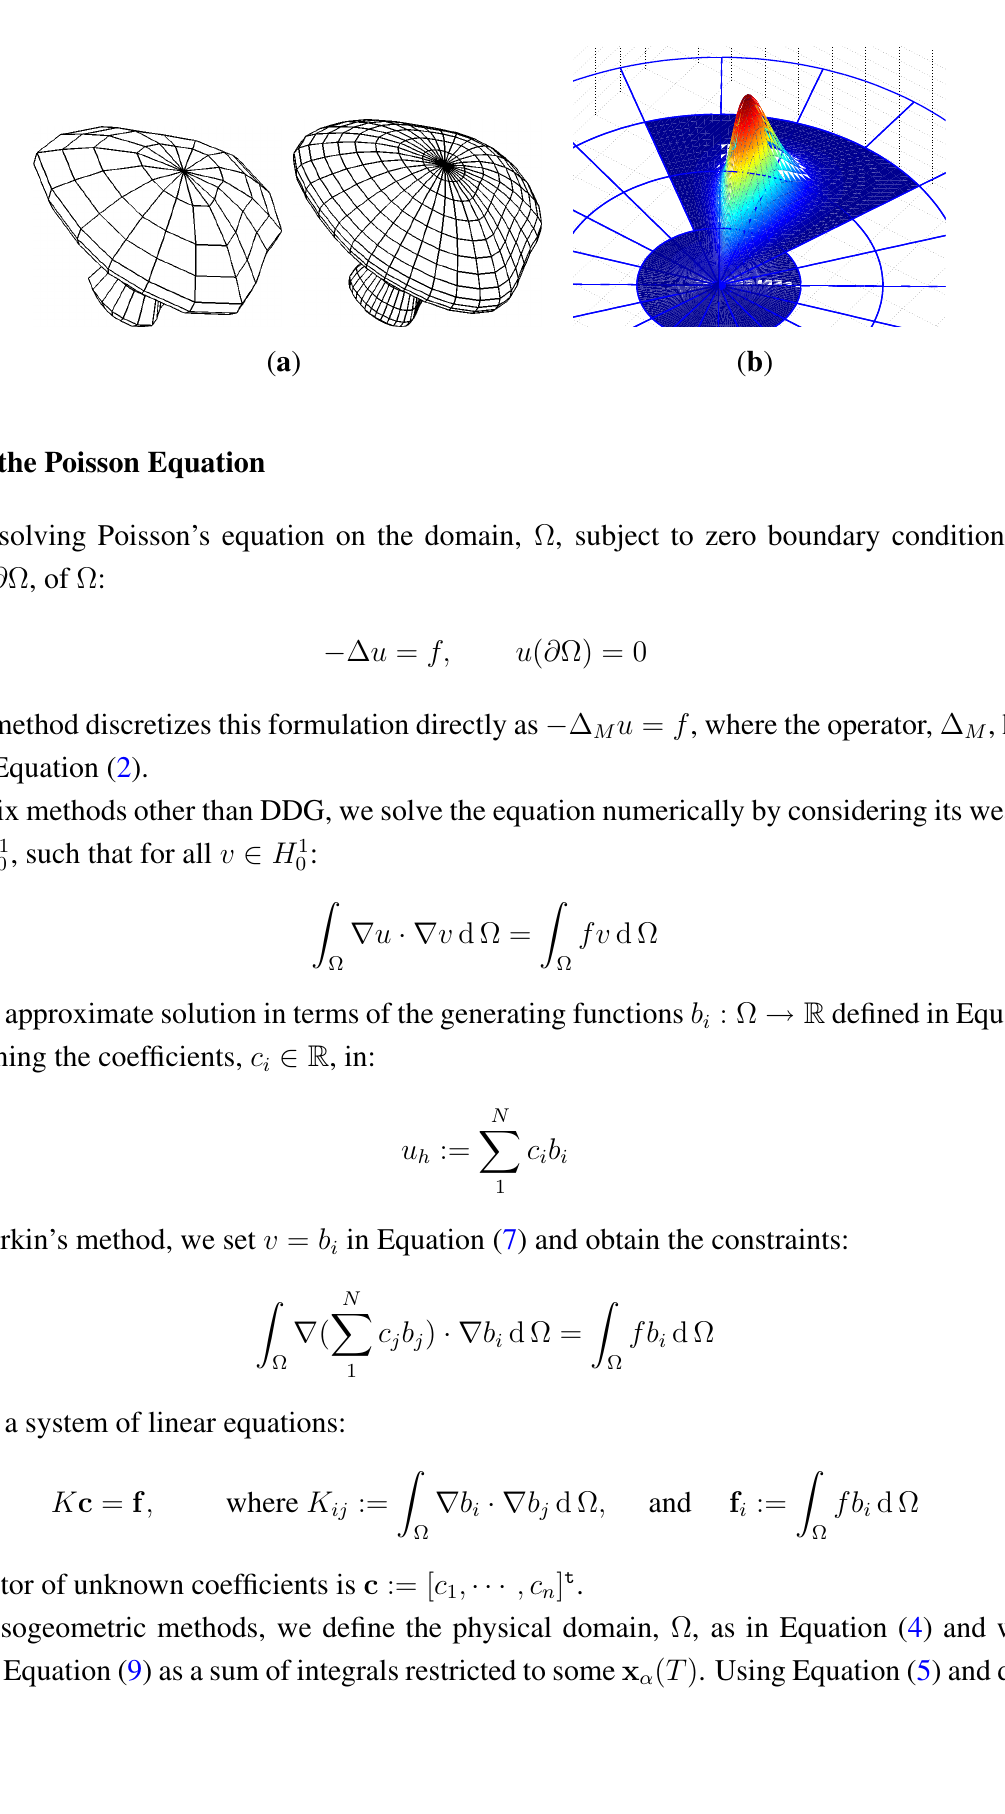
Figure 8. Polar elements for polar configurations. ( a ) Modeling with C 1 polar functions; ( b ) a C 1 polar basis